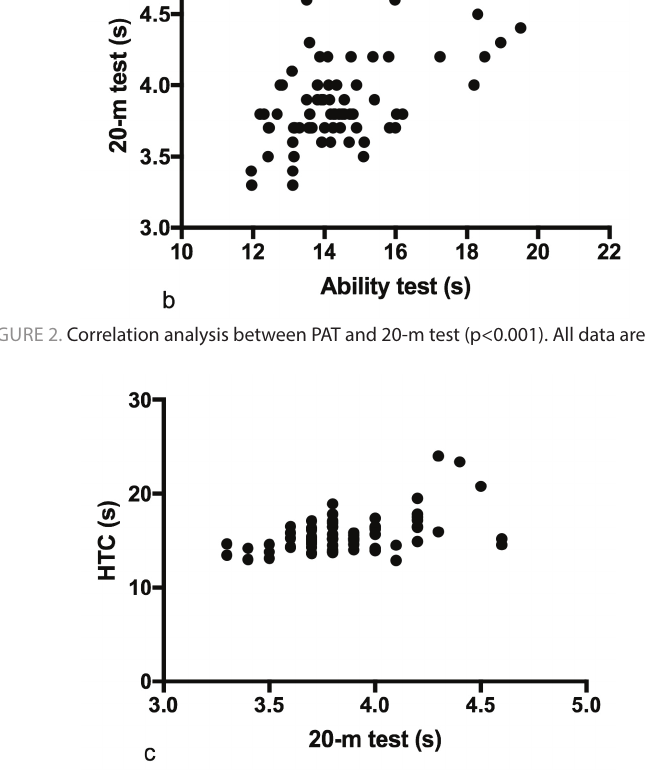
FIGURE 3. Correlation analysis between HTC and 20-m test (p<0.0001). All data are in